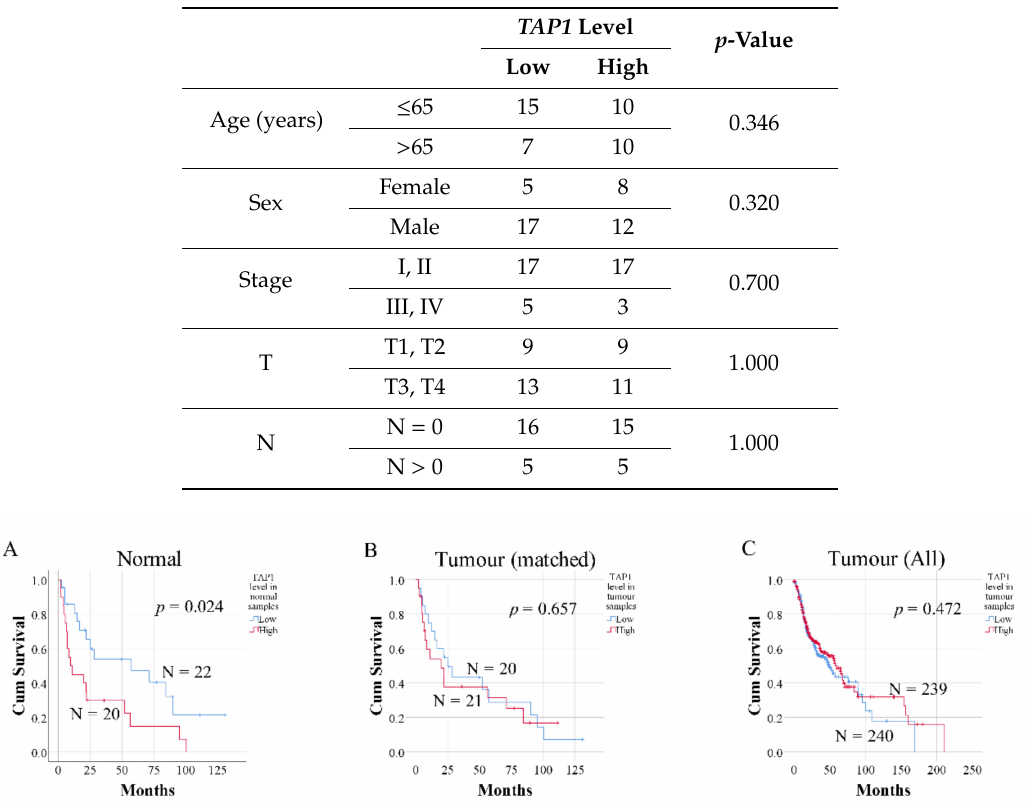
Table 4. Clinical variables and their associations with TAP1 (TCGA data).